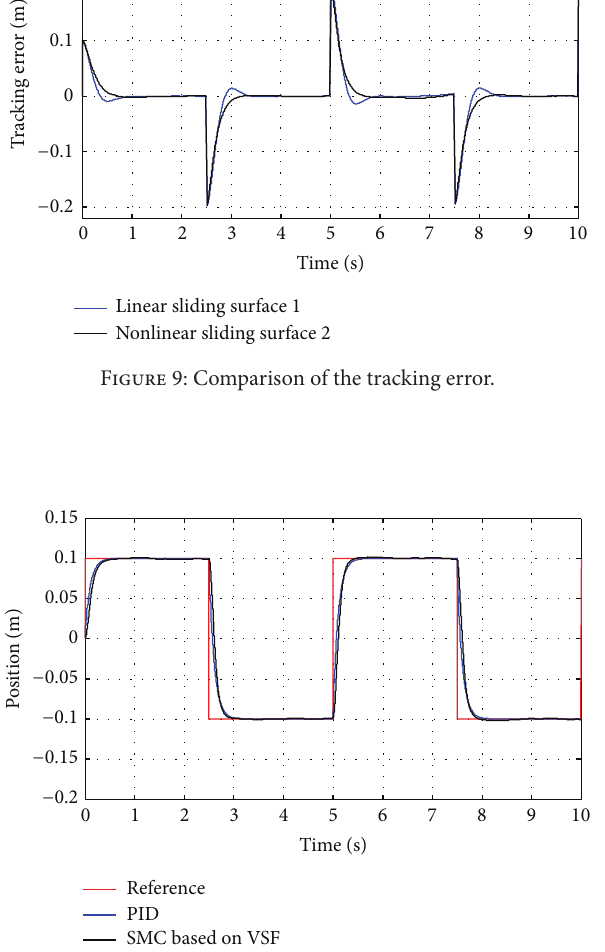
Figure 10: Comparison of the tracking positions when using different